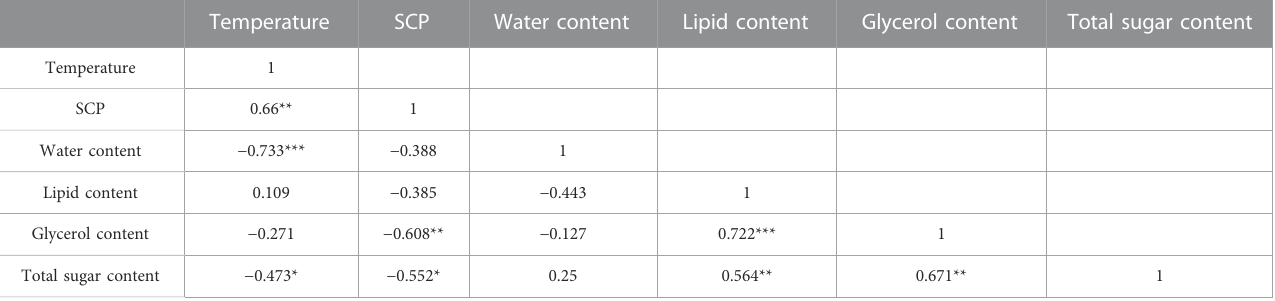
TABLE 2 Spearman correlation coef fi cient matrix among the indexes after long-term low-temperature acclimation of Megabruchidius dorsalis